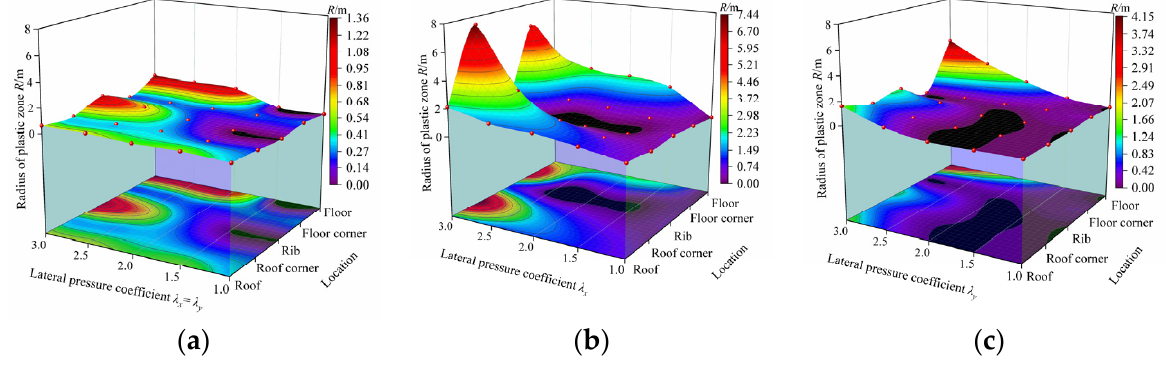
Figure 3. Plastic zone of surrounding rock in different locations of the roadway. ( a ) λ x = λ y ; ( b ) λ x > λ y , λ y = 0.75; ( c ) λ x < λ y , λ x = 0.75.